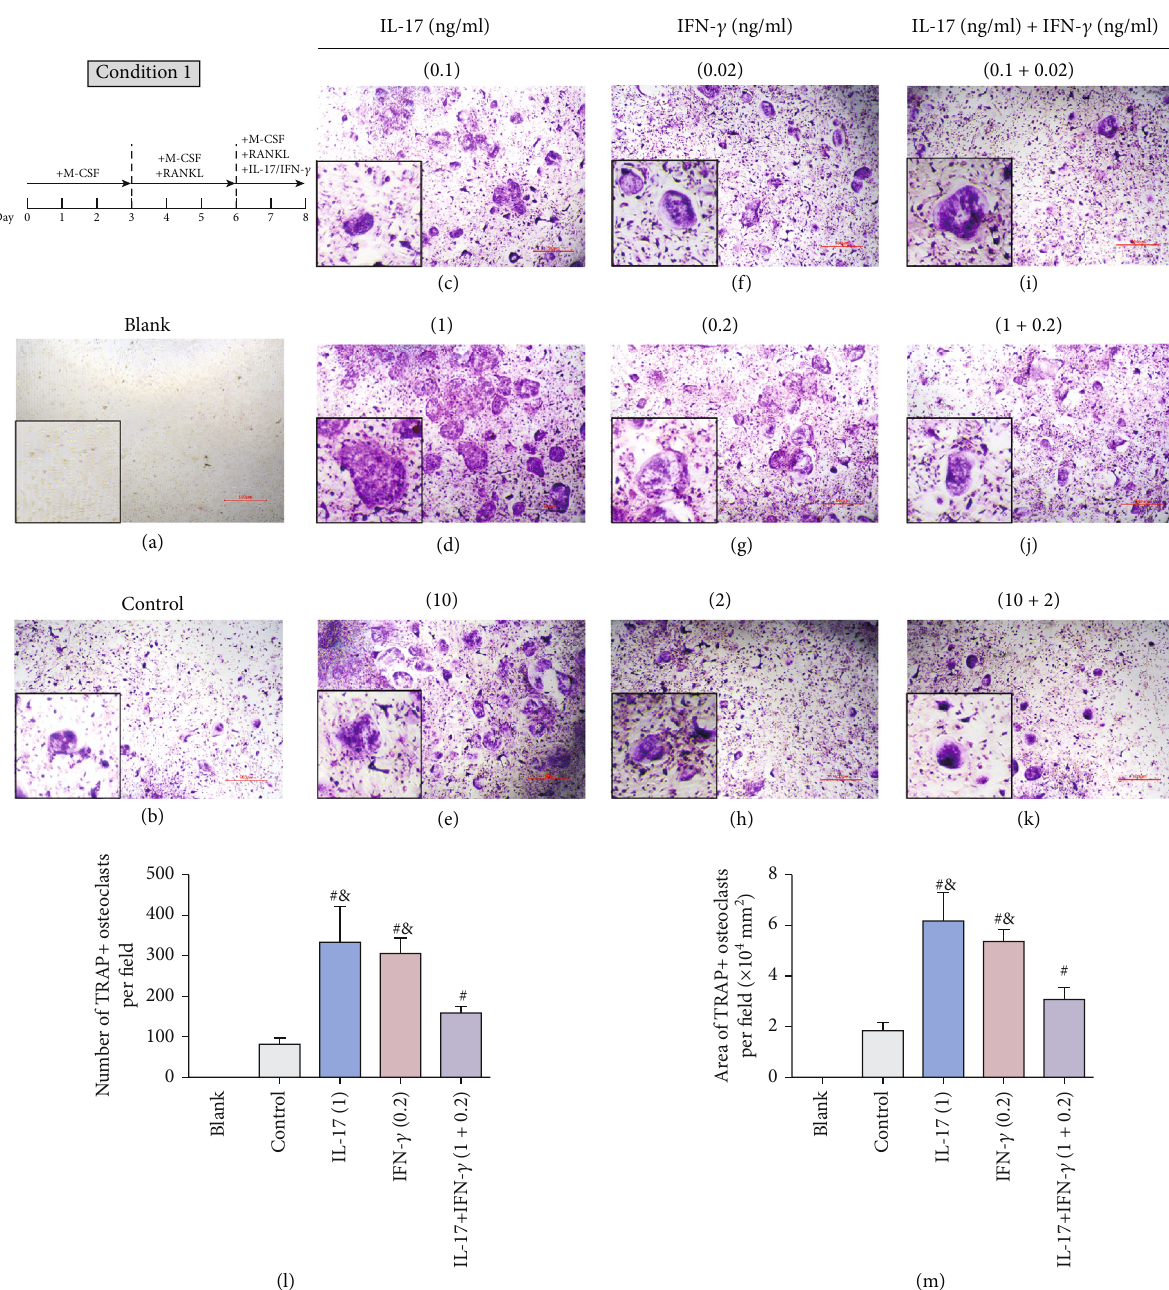
Figure 1: E ff ect of IL-17 or/and IFN- γ on di ff erentiation of preosteoclasts. (a – k) In condition 1, BMMs were cultured with M-CSF (30 ng/ml) for 3 days and then with 20ng/ml RANKL for another 3 days. On day 6, IL-17 or/and IFN- γ of di ff erent concentrations was added. (l, m) The results of TRAP staining of each group are presented ( scale bar = 500 μ m ). Osteoclasts were recognized as TRAP-positive multinucleated cells ( ≥ 3 nuclei). (l) The number of TRAP-positive osteoclasts and (m) the area of TRAP-positive osteoclasts were counted and presented ( mean ± standard deviation , n = 3 ). # p < 0 : 05 compared with the control group; & p < 0 : 05 compared with the IL-17+IFN- γ